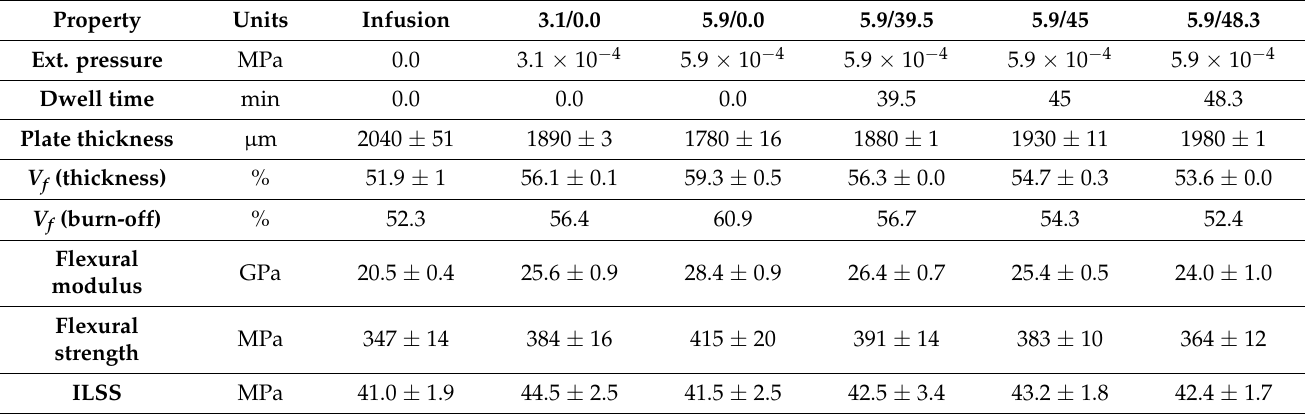
Table 3. Summary of data obtained from laminates manufactured by outlet pipe vented to air